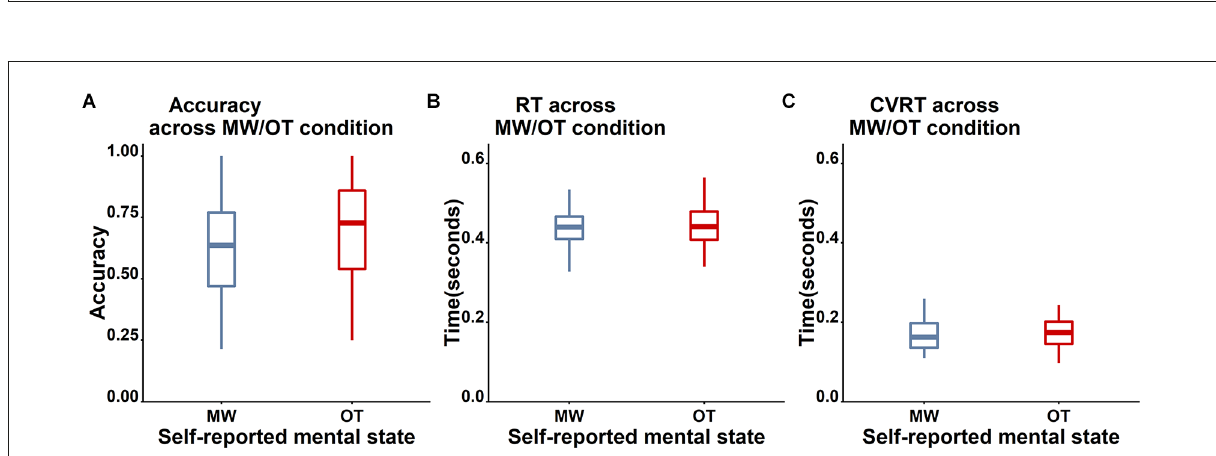
FIGURE7 Comparison of the behavioral performance between mind-wandering (MW, blue) and on-task (OT, red) trials. (A) Accuracy for Nogo trials. (B) RT for Go trials. (C) cvRT for Go trials. No clear differences on these three measures were found between self-reported on-task and mind-wandering